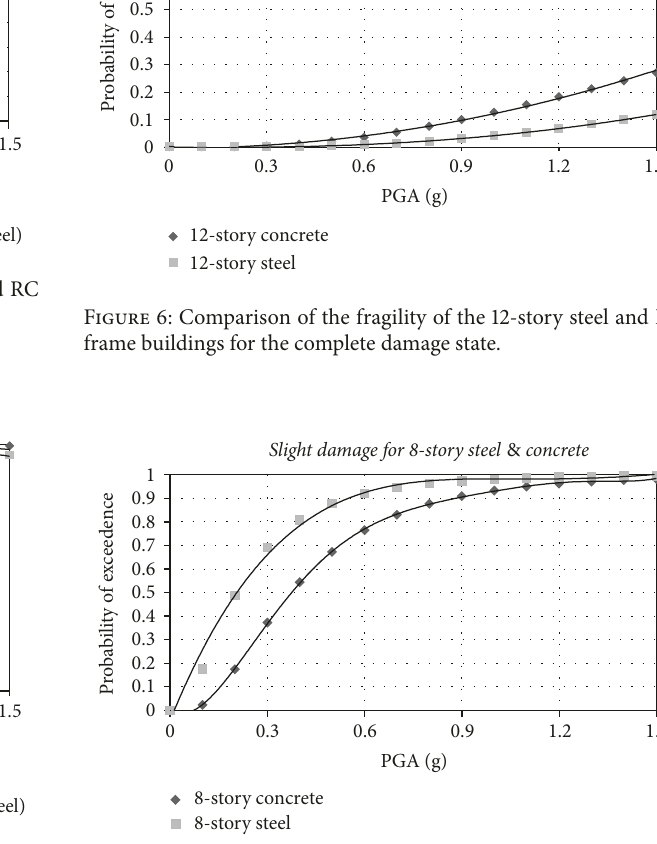
Figure 7: Comparison of the fragility of the 8-story steel and RC frame buildings for the slight damage state.